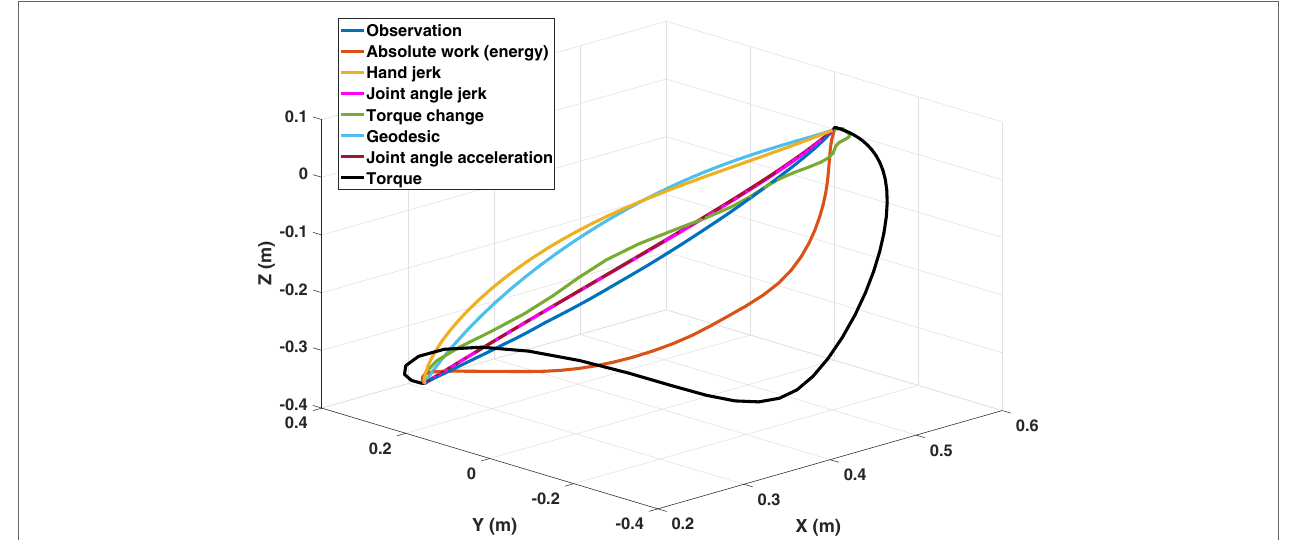
FIGURE 3 | An example of the optimal end-effector trajectories solved from OCPs with respect to different basic cost functions. The variance in their predictions is clear. Only exception is the similarity of the predicted trajectories by minimum joint angle acceleration and the minimum joint angle jerk as they overlap in the